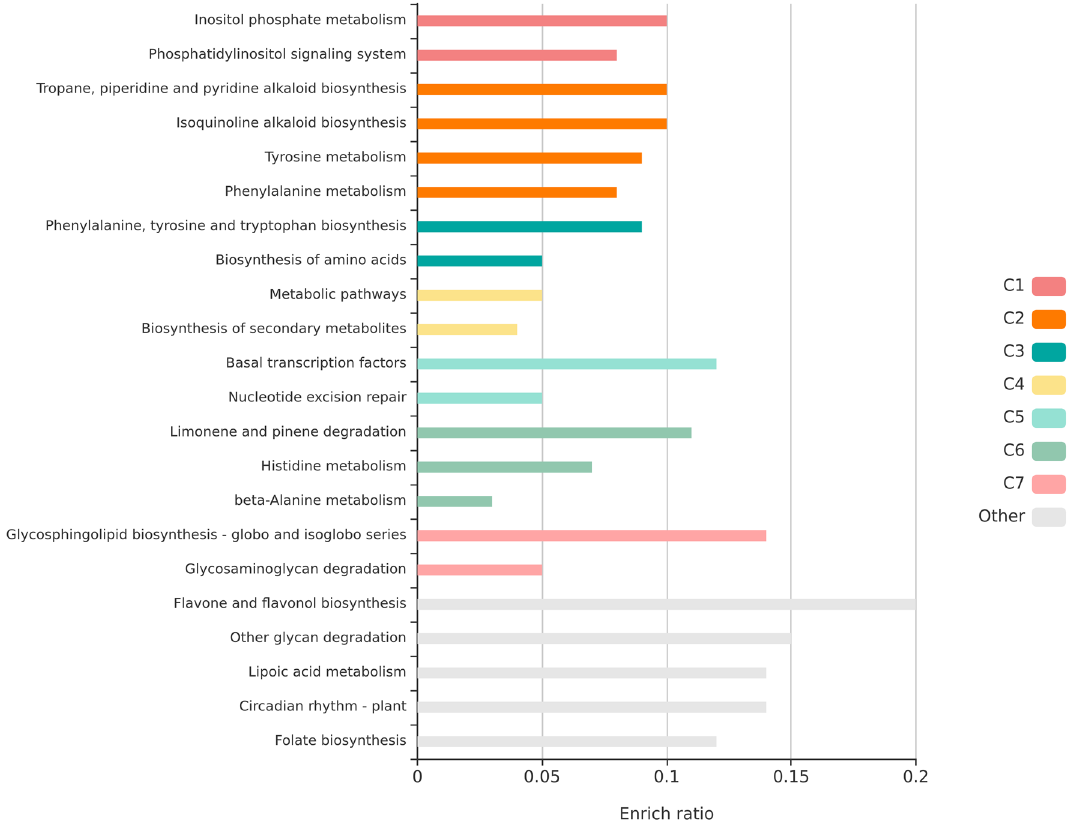
Figure 6. Statistically enriched pathways in the 1586 orthologous groups which were expanding or contracting among the species identified using the KOBAS database. The Y-axis indicates the pathway name and the X-axis indicated Enrich ratio. Enrich ratio is the proportion of the number of differentially expressed genes or proteins in the pathway to the total number of annotated genes or proteins in the pathway. The greater the Enrich ratio, the greater will be the degree of pathway